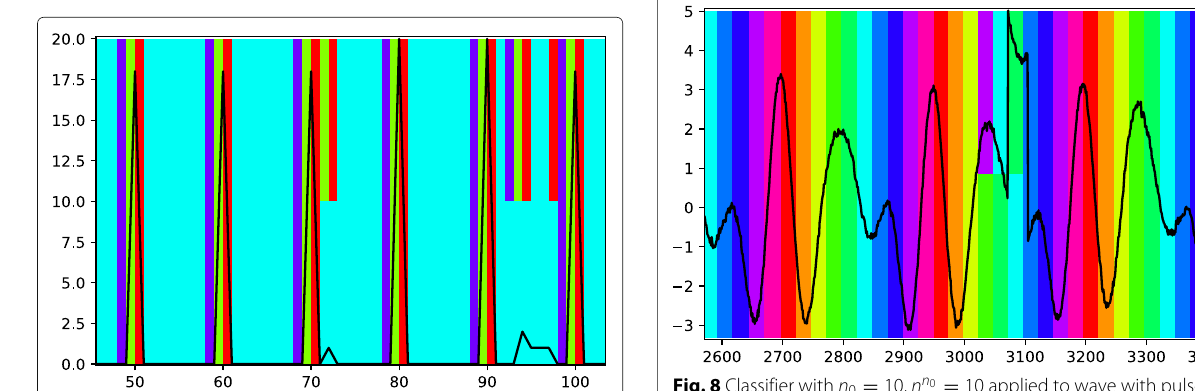
Fig. 7 Classifier applied to test data